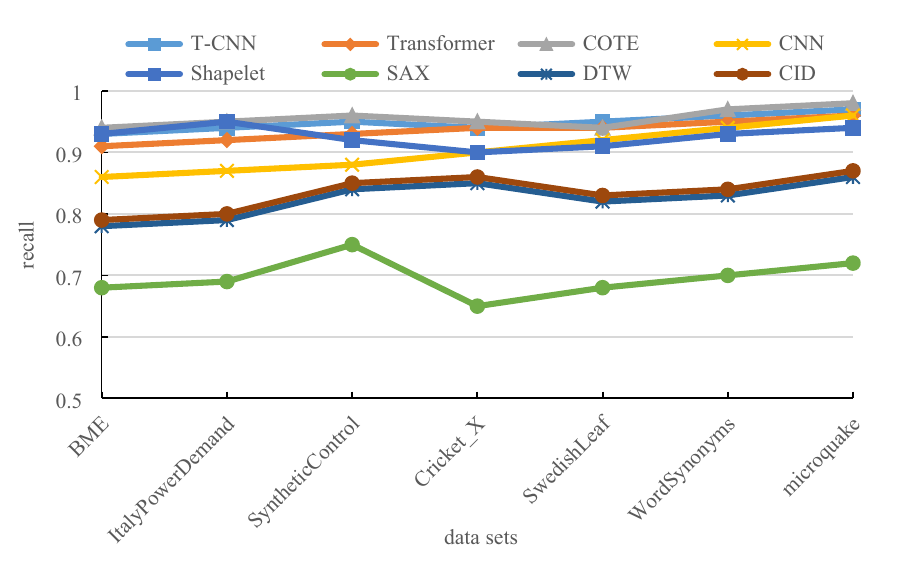
Figure 8. Comparison of classification